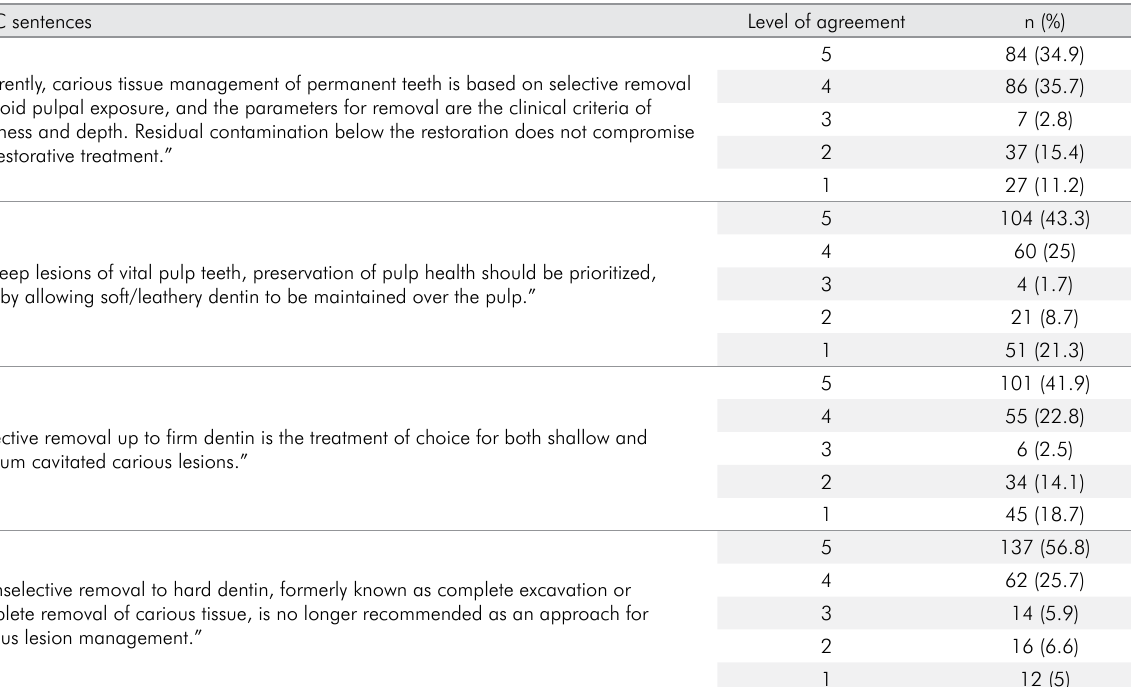
Table 3. ICCC sentences and level of agreement (1 - totally disagree, 2 - partially disagree, 3 - do not know, 4 - partially agree, 5 - totally